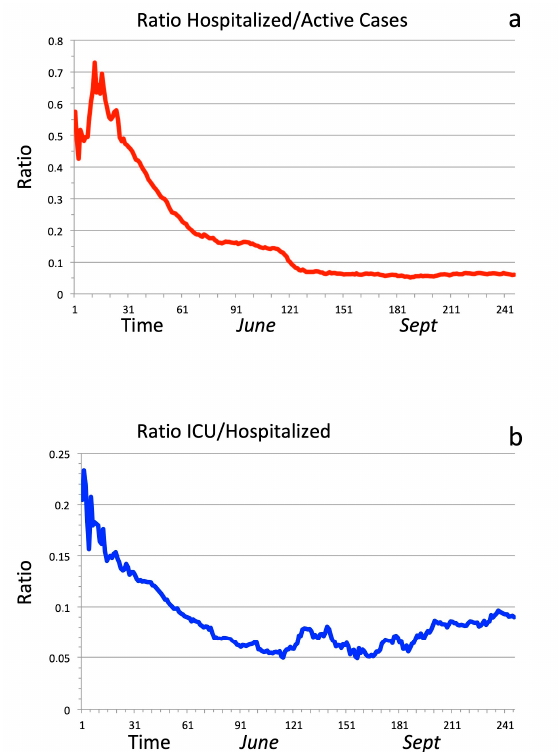
Figure 4. ( a ) Ratio between hospitalized Covid-19 patients and total number of active cases, in Italy; ( b ) ratio between ICU occupation and hospitalized patients. The considered period is February 24th (indicated as day 1) to October 23rd.